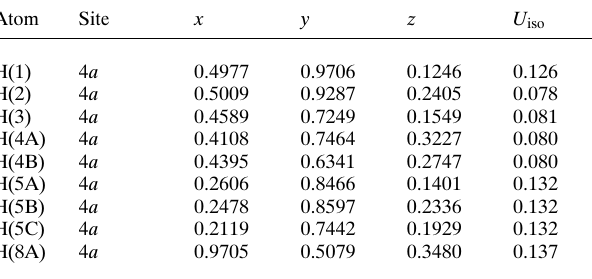
Table 2. Atomic coordinates and displacement parameters (in Å 2 )